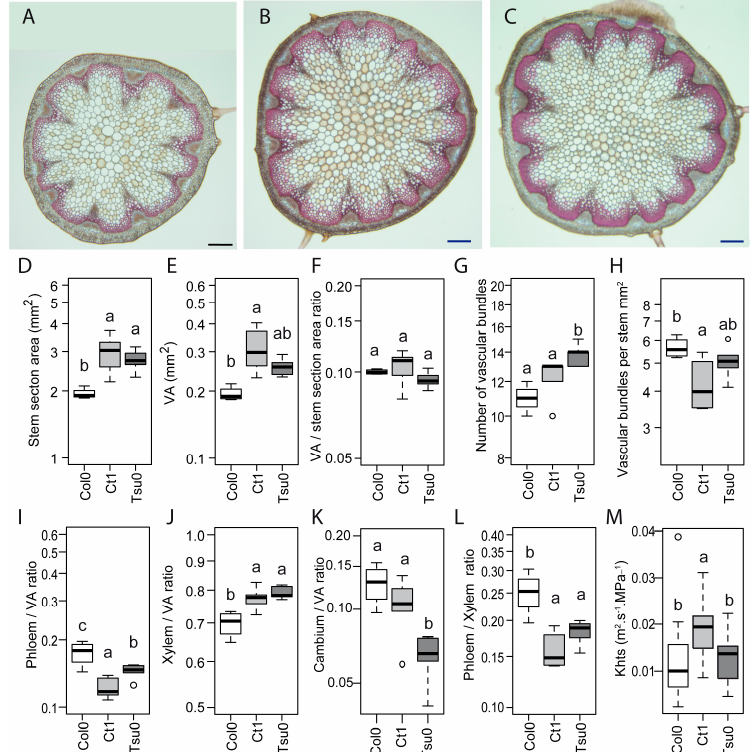
Figure 7. Natural variation of the anatomy in the stem of Arabidopsis plants at 17 DAB. ( A – C ) Representative stem sections of the Col0 ( A ), Ct1 ( B ) and Tsu0 ( C ) plants, with counterstaining with Safranin O and Alcian Blue. Bars = 200 µm. ( D – M ) The box and whisker plots represent the distribution of the biological replicates (see Figure 2 for details), for the stem section area ( D ), vascular area per stem section (VA) ( E ), vascular area/stem section area ratio ( F ), number of vascular bundles per section ( G ), number of vascular bundles per stem section area ( H ), phloem area/vascular area ratio ( I ), xylem area/vascular area ratio ( J ), cambium area/vascular area ratio ( K ), phloem area/xylem area ratio ( L ), and theoretical specific hydraulic conductivity (Khts) ( M ). Different letters indicate significant differences among accessions determined using a one-way analysis of variance (ANOVA) combined with Tukey’s comparison post-test ( p < 0.05, n = 4–6, except for Khts, with n > 45).